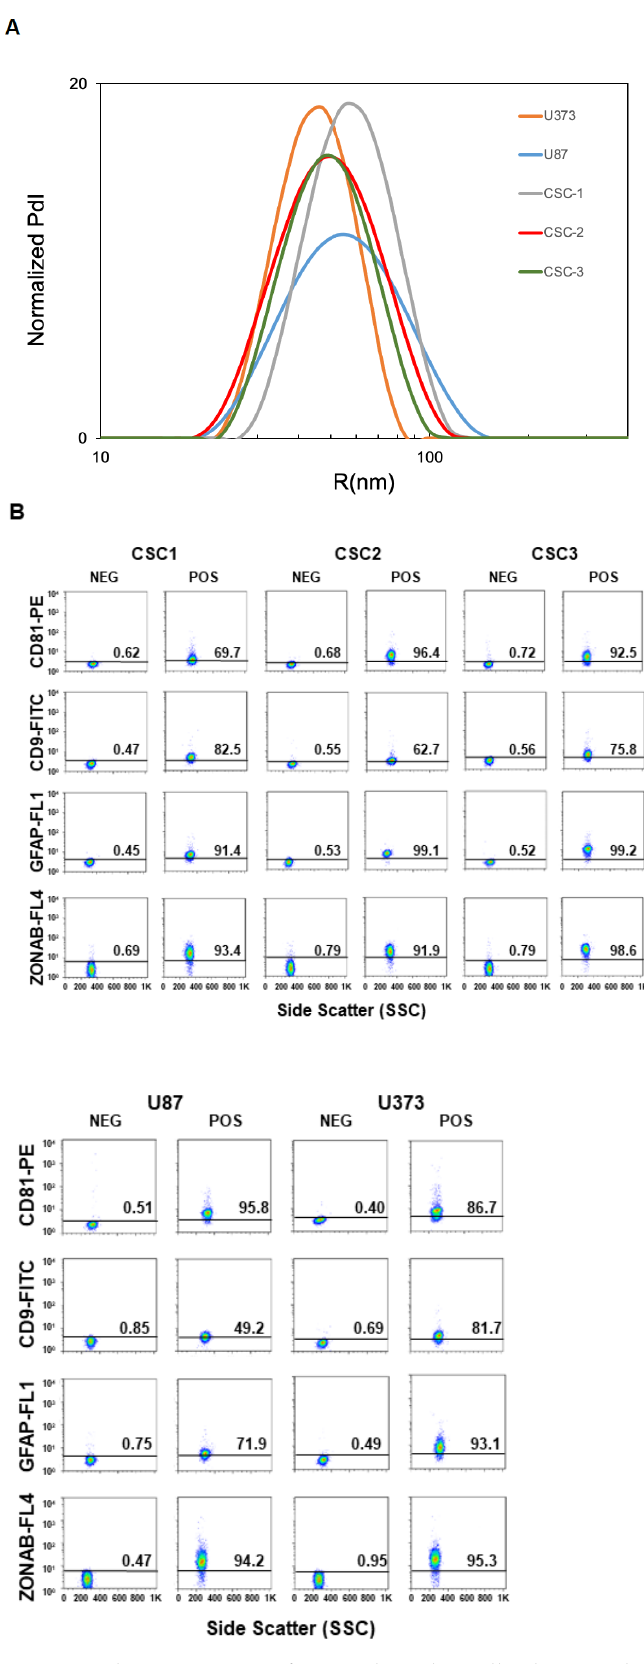
Figure 1. Characterization of sEVs released in cell culture media by U87, U373, and GBM primary CSCs. ( A ) Size of the released sEVs was measured via dynamic light scattering. The